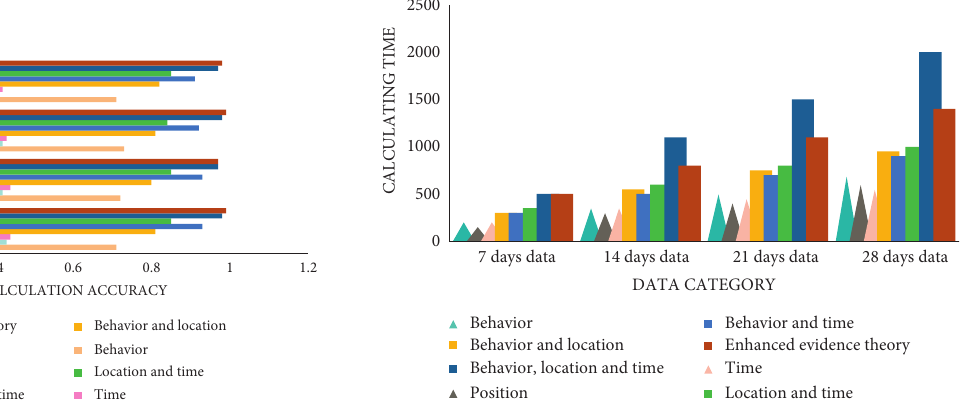
Figure 7: Calculation time of evidence